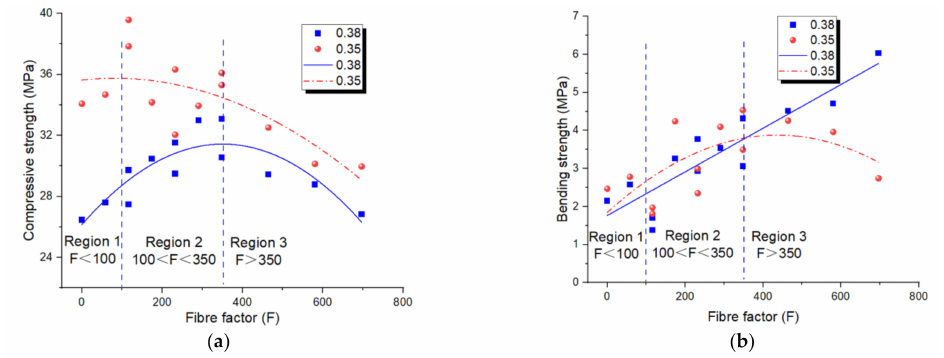
Figure 5. Relationships of ( a ) fibre factor–compressive strength; ( b ) fibre factor–bending strength of PP fibre-reinforced